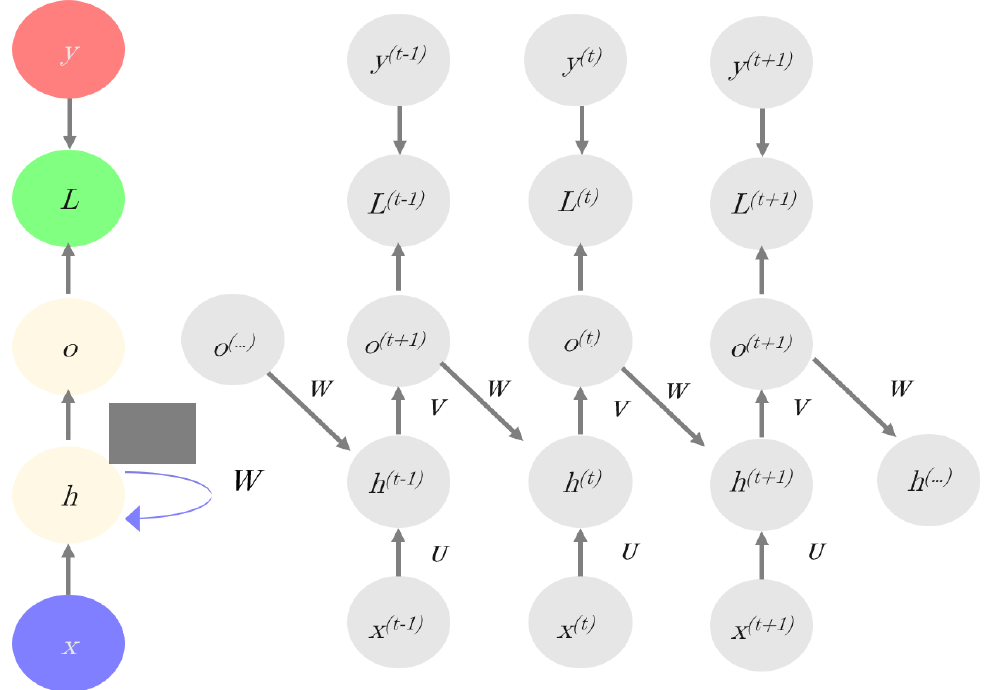
Figure 3. Scheme of recurrent neural networks (RNNs): The left part of the image (in colors) shows the whole network structure; whereas, the recursive structure of the network is shown in the right, where x represents inputs, h are the hidden layers, o = Vh ( t ) + b are the outputs (Equation (4b)), y are the target variables, and L is the loss function.